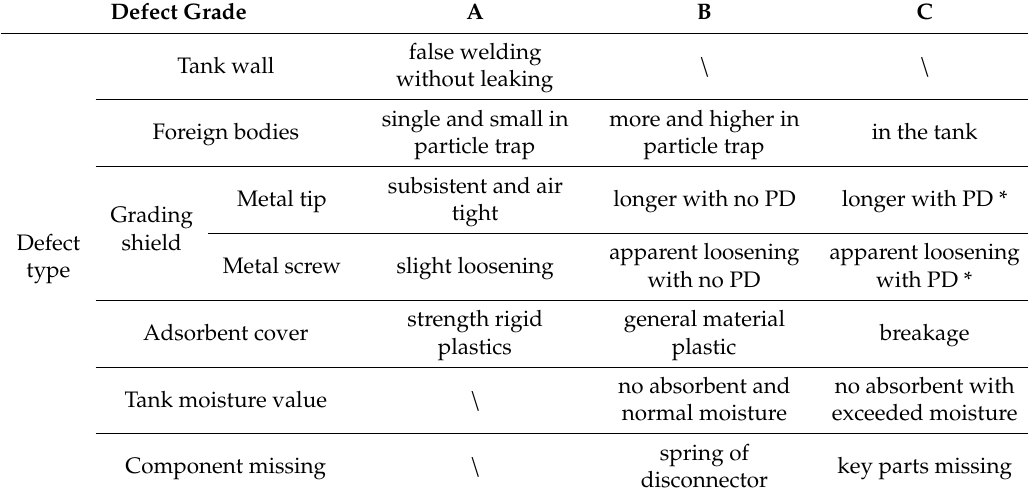
Table 2. Risk assessment of typical defects in gas insulated switchgear